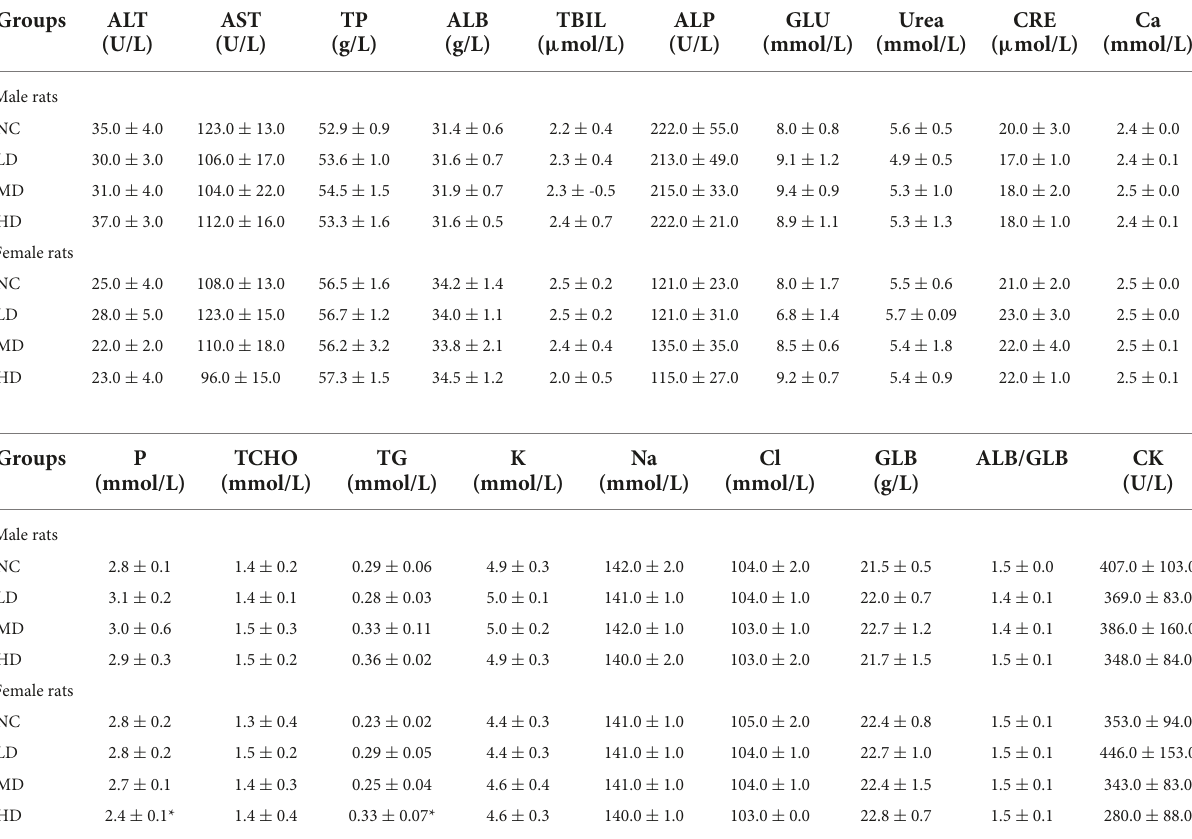
TABLE 3 Effects of aqueous extracts of Cyclocarya paliurus leaves on the serum chemistry of Sprague-Dawley (SD) rats in the acute toxicity study. Groups